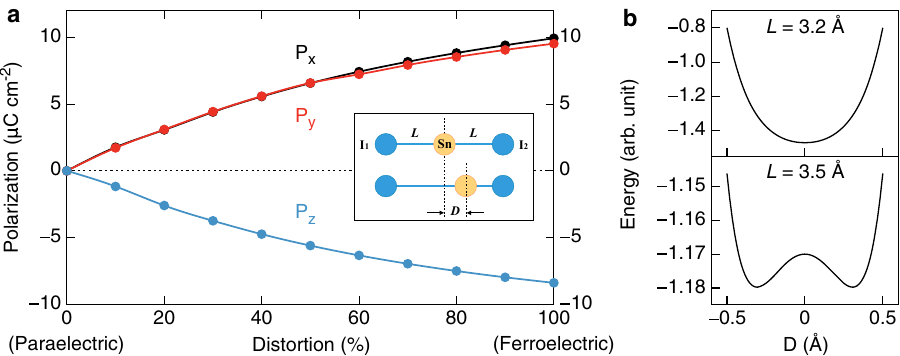
Fig. 4 Spontaneous polarization and the I – Sn – I model for explaining the ferroelectricity mechanism. a Polarization of the 3D-cubic R3m N(CH 3 ) 4 SnI 3 as a function of the atomic distortion from the paraelectric to the ferroelectric phase. The black, red, and blue lines indicate P x , P y , and P z component of polarization, respectively. Inset: illustration of the linear I – Sn – I model. b The total energy as a function of the Sn 2 + displacement for L = 3.2 and 3.5 Å, respectively.